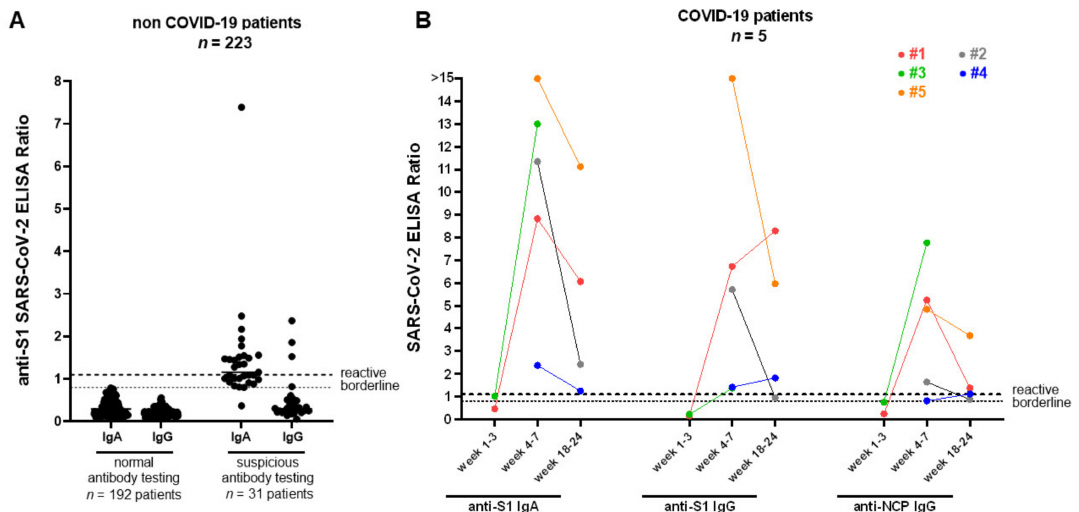
Figure 2. SARS-CoV-2 IgA and IgG responses for non-COVID-19 and COVID-19 patients in the kidney transplant recipients (KTR) cohort. ( A ) Spike (S1) IgA and IgG antibodies from 223 non-COVID-19 (black dots) patients were measured using a commercial ELISA. Of the non-COVID-19 patients, 192 were IgA and IgG negative and 31 patients showed borderline / reactive results. ( B ) anti-SARS-CoV-2 S1 IgG, anti-SARS-CoV-2 S1 IgA, and anti-SARS-CoV-2 NCP (nucleocapsid) IgG from 5 PCR-confirmed COVID-19 patients (colored dots) were detected at 1–3 weeks (case 1 and 3), 4–7 weeks, and 18–24 weeks (cases 1, 2, 4, and 5) after symptoms onset, respectively (see also supplementary Table S1 for further details regarding patients characteristics). All COVID-19 patients underwent a seroconversion 4 to 7 weeks after symptom onset. SARS-CoV-2 = severe acute respiratory syndrome coronavirus 2,